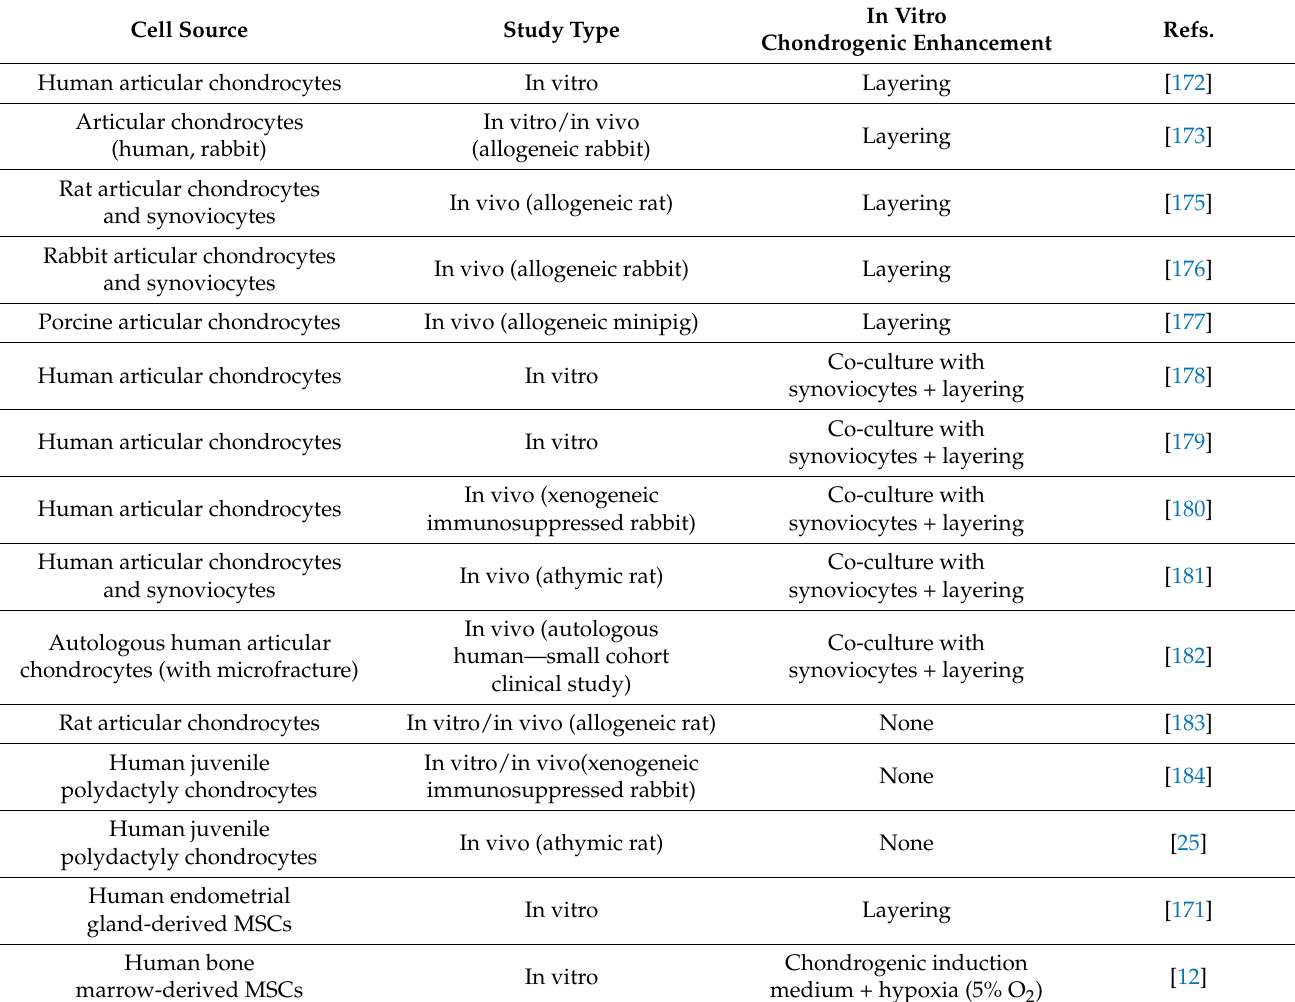
Table 2. Cell sheet tissue engineering cartilage regeneration